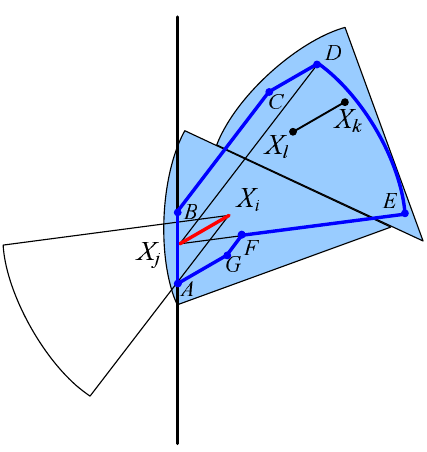
Figure 6. The proof of Theorem